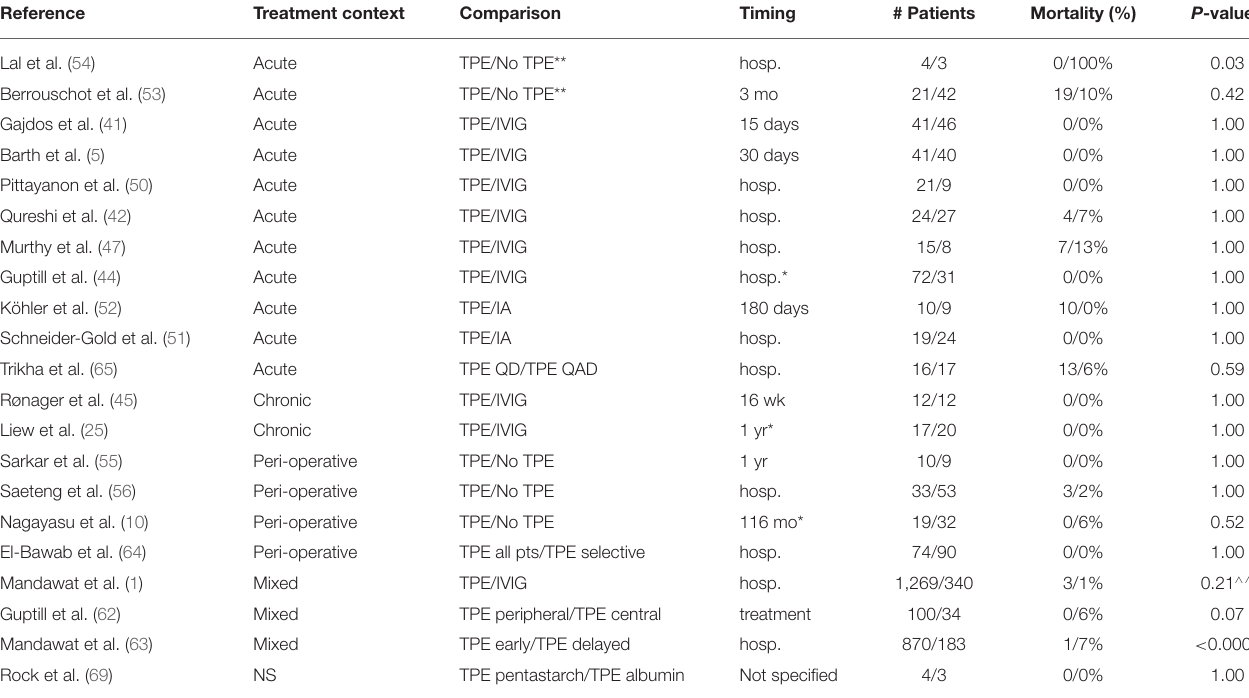
TABLE 7 | Comparative all-cause mortality data for TPE in